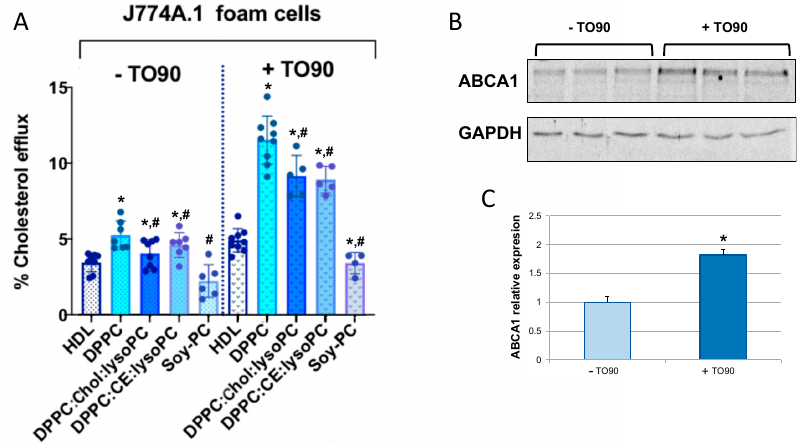
Figure 4. Effect of HDL, DPPC, DPPC:Chol:lysoPC, DPPC:CE:lysoPC and Soy-PC rHDLs on cholesterol efflux in ( A ) murine J774A.1 derived foam cells and murine J774A.1 derived foam cells stimulated with TO90. ( B ) ABCA1 levels in both TO90 stimulated and non-stimulated foam cells. ( C ) Expression levels of ABCA1 determined by optical density. rHDLs were added to the stimulated and non-stimulated cells in MEM-Hepes 25 mM (pH 7.4) containing 2 µg/mL ACAT inhibitor and incubated during 6 h to promote cholesterol efflux. Cholesterol efflux was calculated as described in Methods. The data in A and C, represent the means ± S.D. of at least three independent measurements. Figure 4B correspond to a representative western blot of n = 3. Levels of significance were determined by a two-tailed Student’s t -test. * p < 0.01 compared to HDL and # p < 0.01 compared to DPPC. Biomedicines 2020 , 8 , x FOR PEER REVIEW